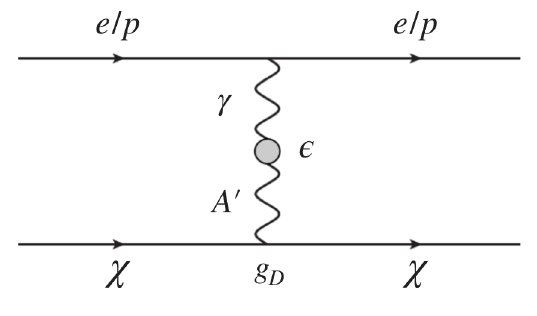
Figure 4. Light dark matter interaction processes which can be probed by the SHiP experiment within the Scattering Neutrino Detector, i.e. elastic scattering off electrons ( χ e − → χ e − ) and off protons ( χ p → χ p )